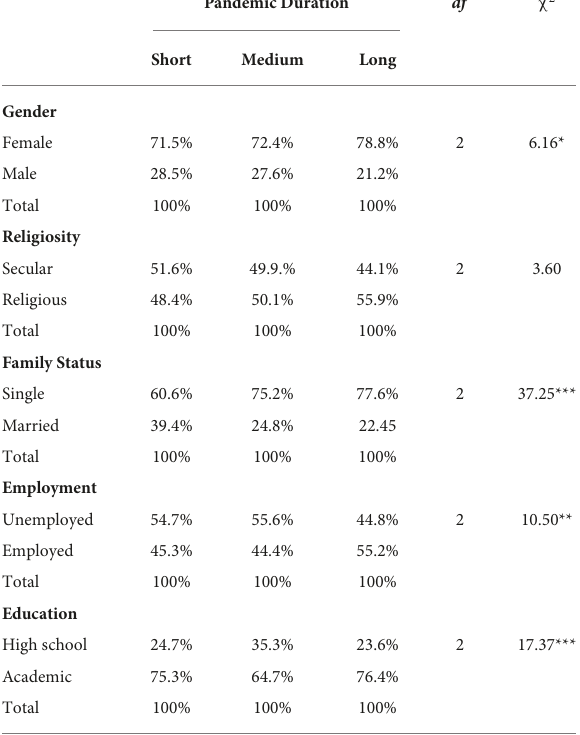
TABLE 1 Associations between the demographic characteristics and pandemic